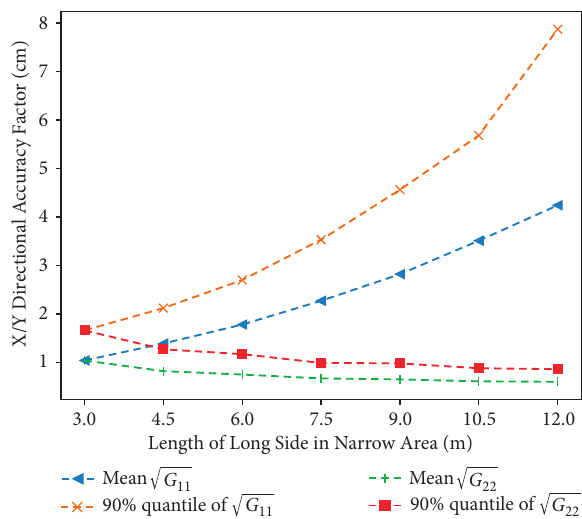
Figure 4: Directional factor changes with rectangular